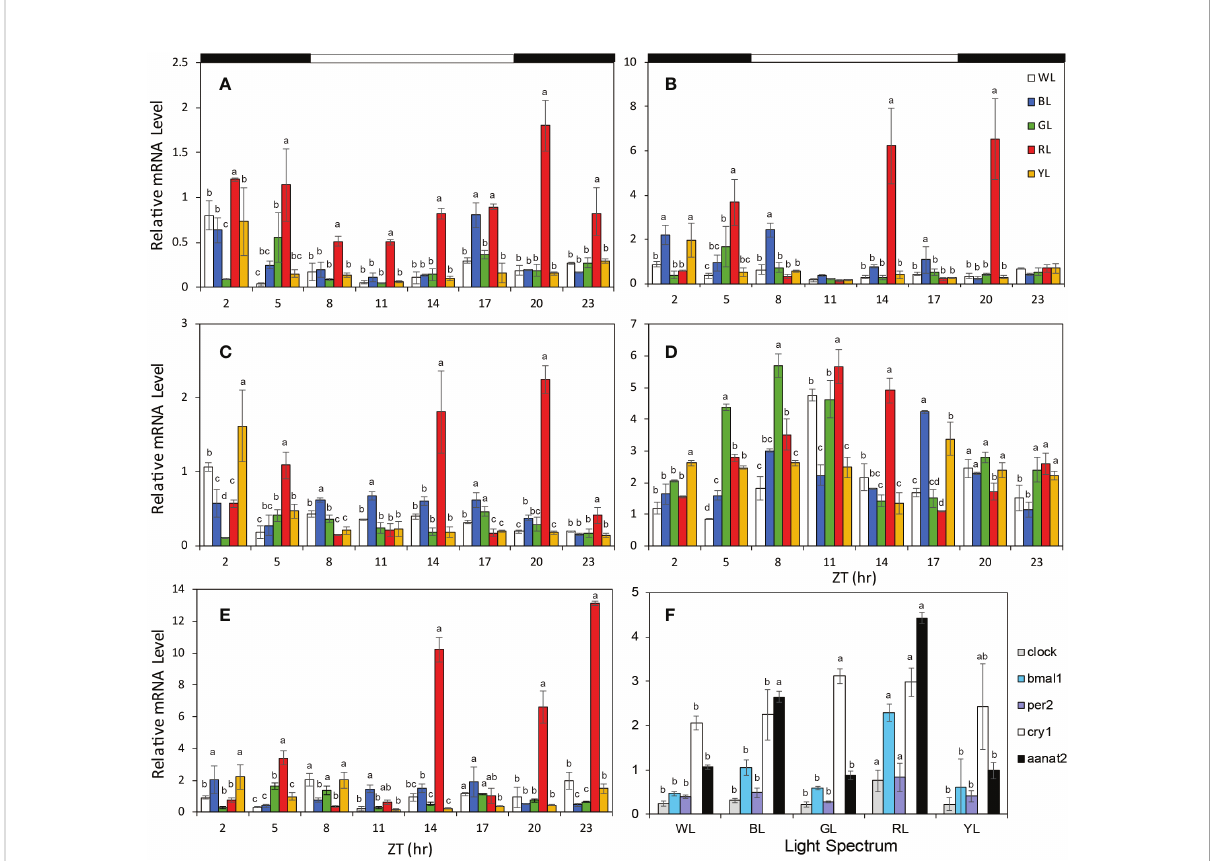
FIGURE 2 The relative mRNA levels of clock genes and Aanat2 in brains under different light treatments. (A) Clock , (B) Bmal1 , (C) Per2 , (D) Cry1 , (E) Aanat2 . (F) Average expressions of all clock genes and Aanat2 under different light. The horizontal white bars on the top of fi gures represent the light period, and the black bars represent the dark period. The data is shown as the mean ± SEM. N = 3 brains per time point. The different letters upon the bars indicate signi fi cant difference among the fi ve light groups at each time point. (p < 0.05), post hoc LSD. ZT, zeitgeber time; WL, white light; BL, blue light; GL, green light; RL, red light; t; YL, yellow